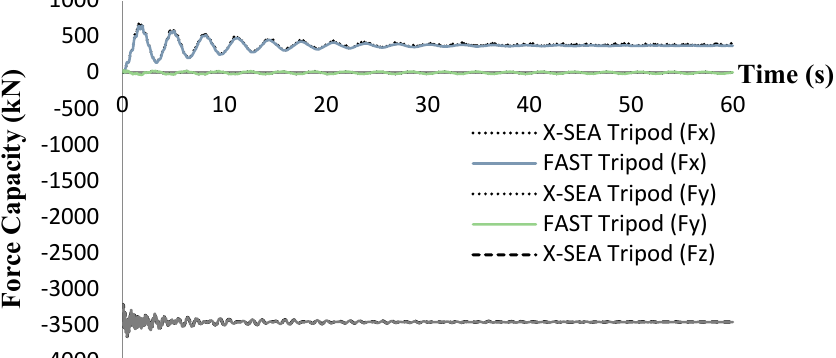
Figure 10. A comparison of natural frequency values of the tripod support structure resulting from the X-SEA and FAST programs.